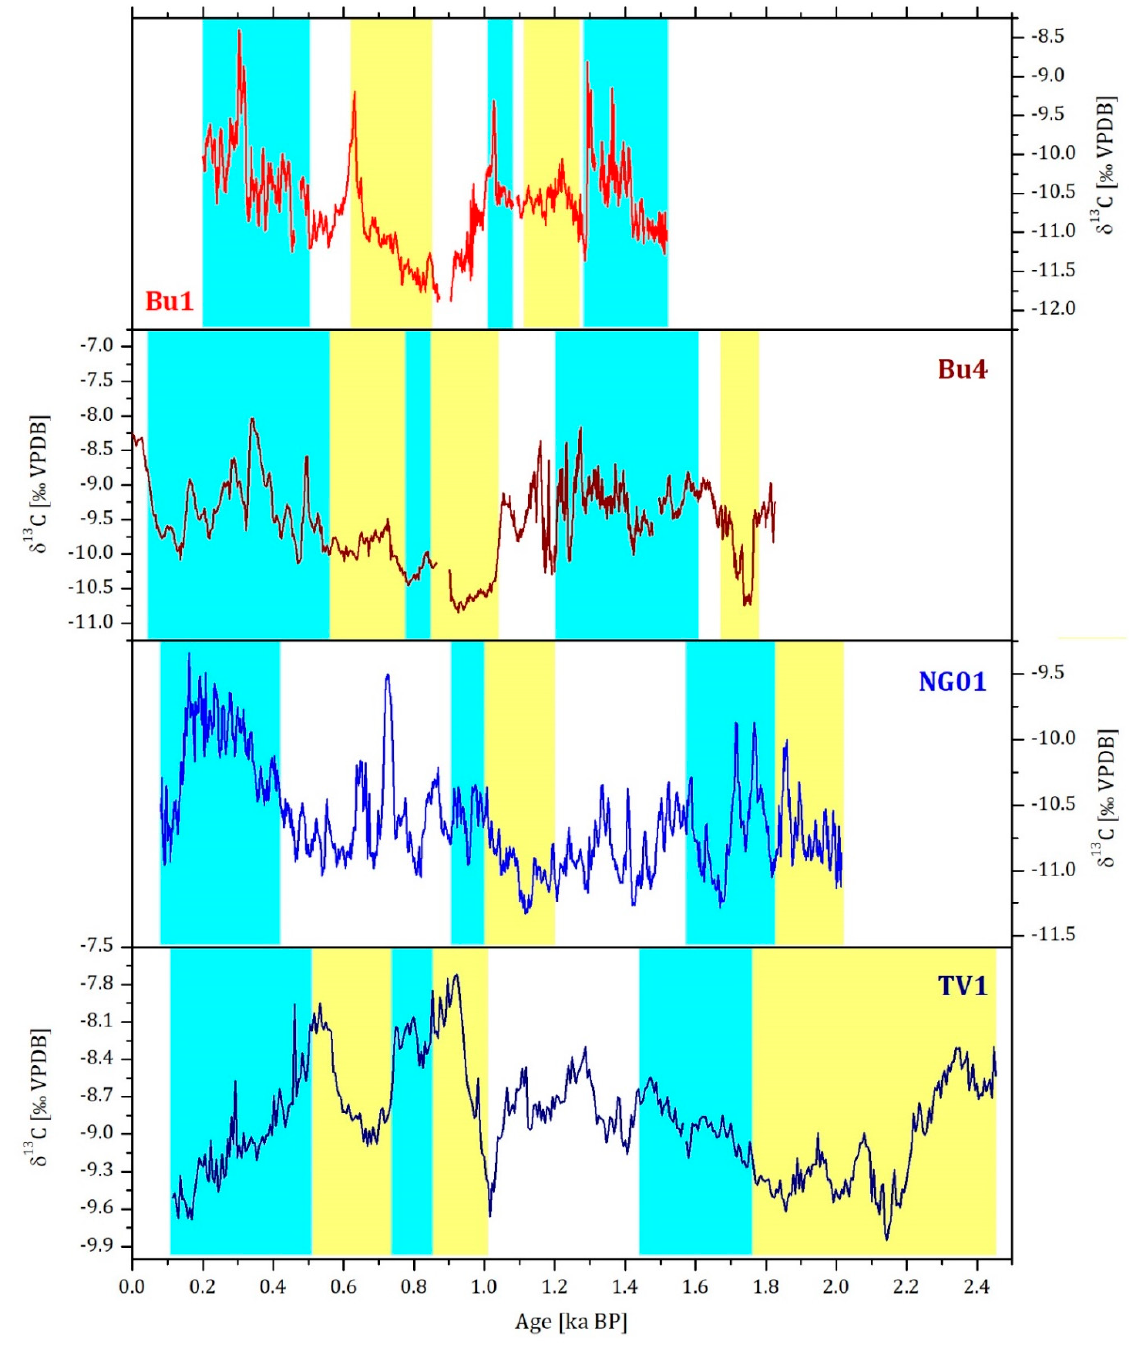
Figure 4. Stable carbon isotope records of speleothems Bu1 and Bu4 from Bunker Cave as well as stalagmites NG01 and TV1 from the Herbstlabyrinth cave system. Blue bars indicate periods of higher δ 18 O values and yellow bars periods of lower δ 18 O values (cf. Figure 3).